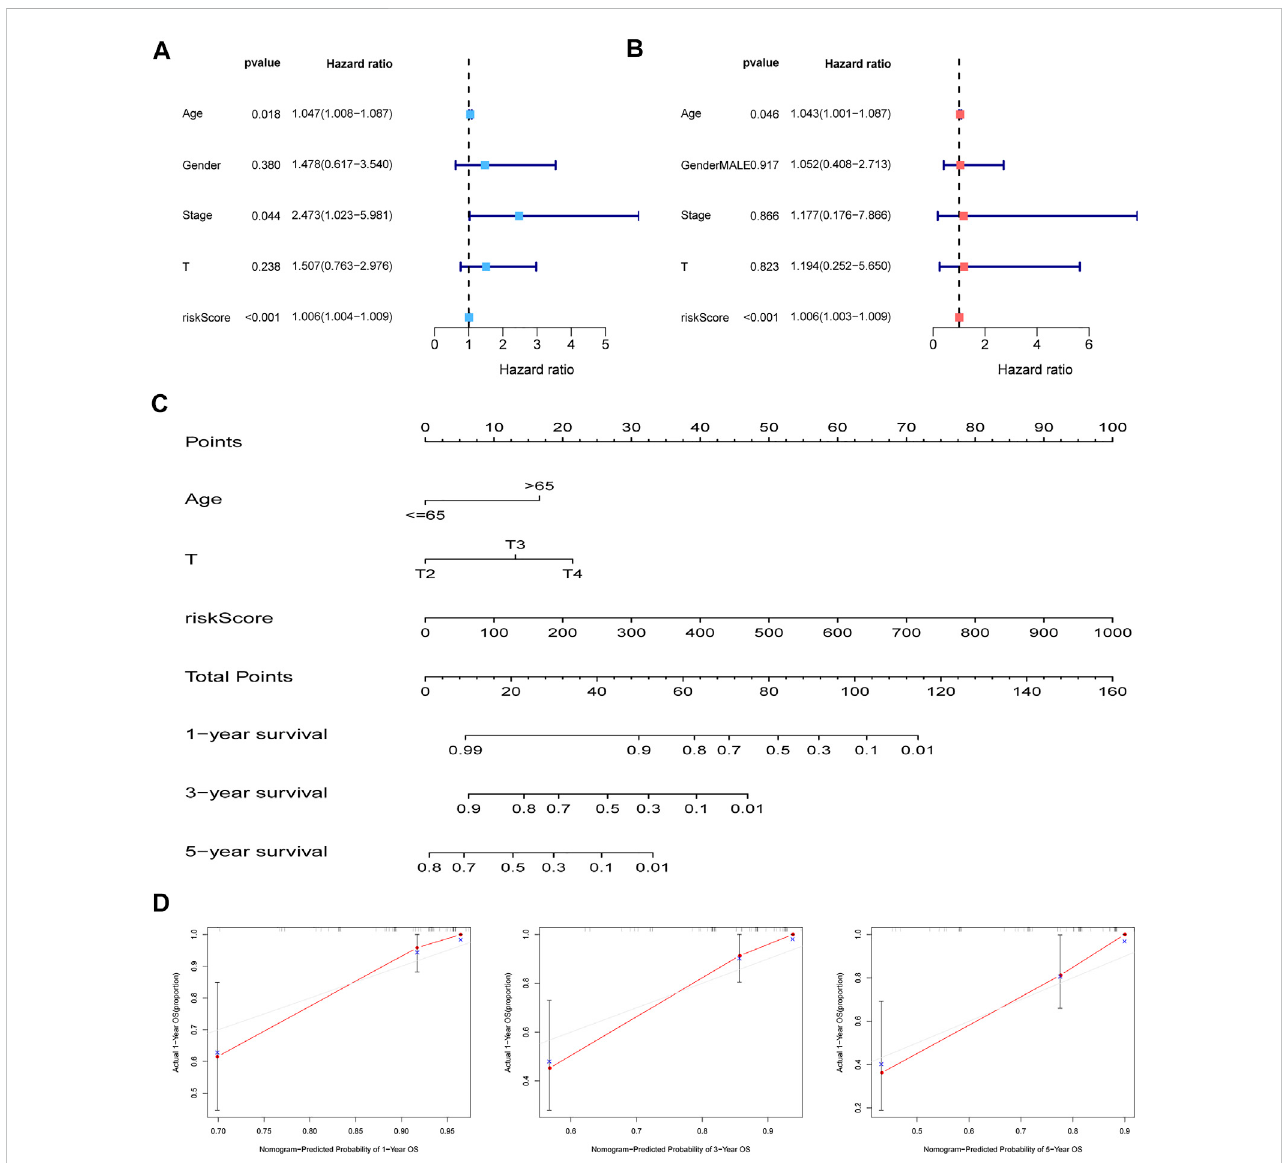
FIGURE 5 Establishment of the nomogram. (A – B) independent prognosis analysis by univariate and multivariate analyses. (C) Nomogram for improving prognosis assessment. (D) Calibration curves of the